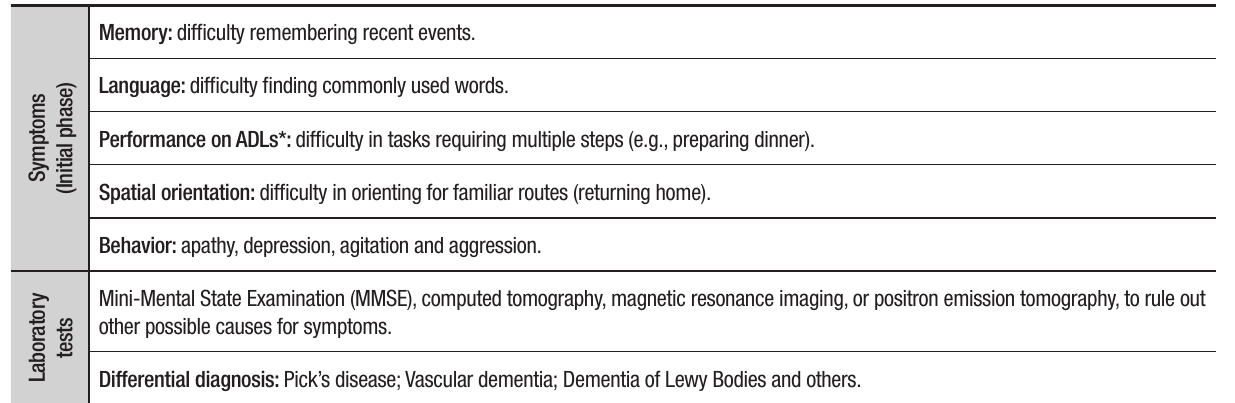
Table 1. Diagnostic criteria for Alzheimer’s